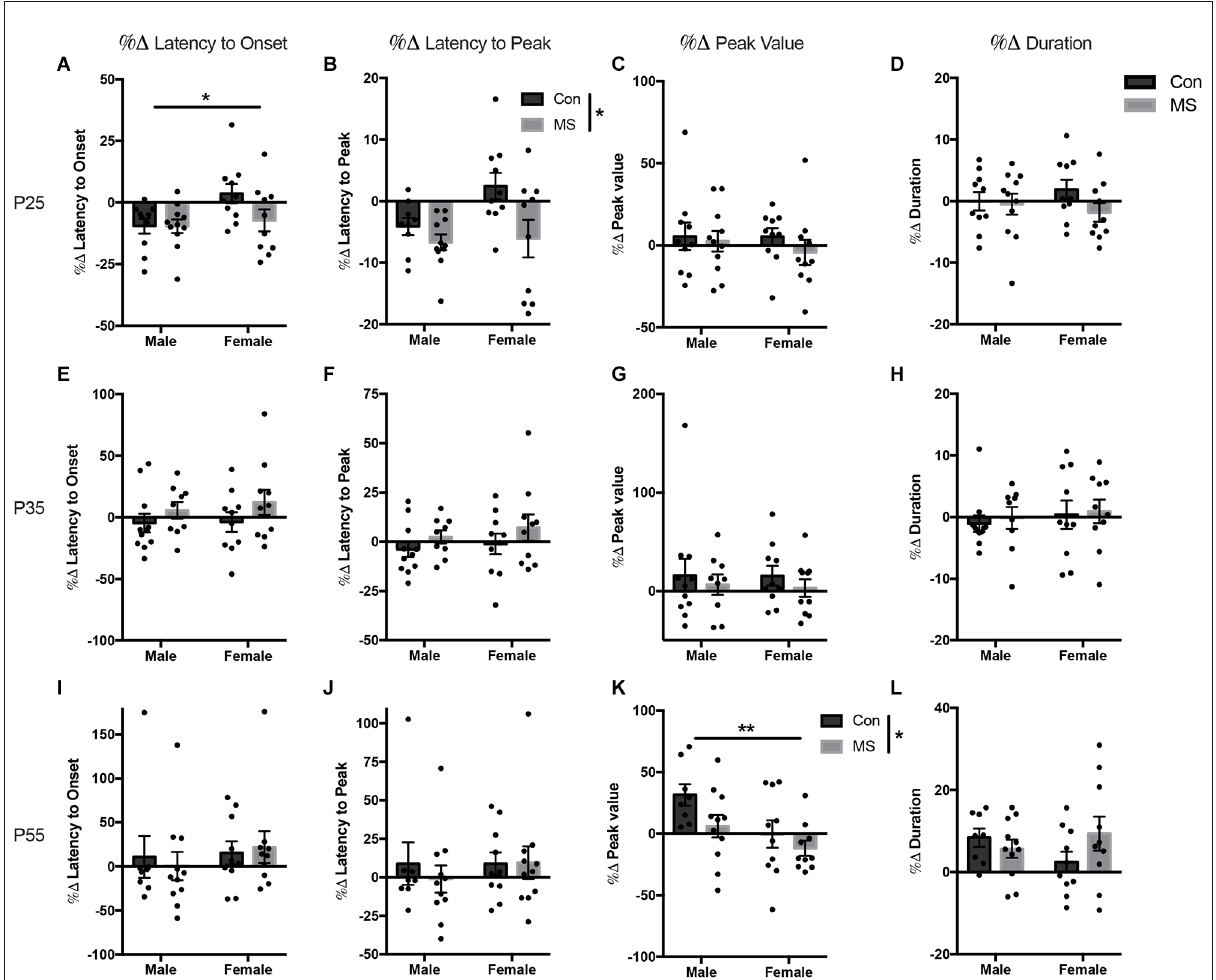
FIGURE3 Results from Experiment 1b, the effects of maternal separation (MS) on the change in startle response from baseline after exposure to 22 KHz USVs. Graphs depict the change in each measure as a percentage of the value from the baseline test. Percent change from baseline in latency to onset, latency to peak, peak value, and duration on P24 (A–D) , P34 (E–H) , and P54 (I–L) . Control-reared groups are depicted by dark gray bars and MS-reared groups are depicted by light gray bars. Figures represent the mean group values ± SEM. Individual subjects are depicted by data points. * p < 0.05, ** p <